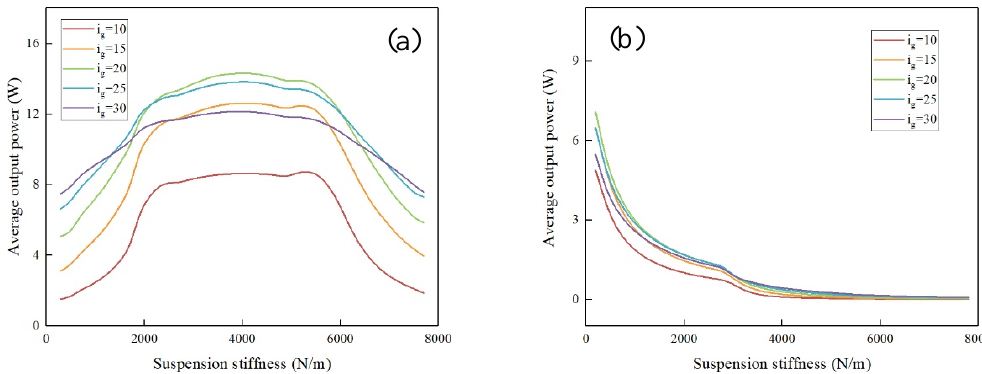
Figure 3. Average output power versus spring stiffness under different gear ratios with walking velocity v = 5.5 km / h and load mass m l = 15 kg: ( a ) Slip model; ( b ) Swing model.